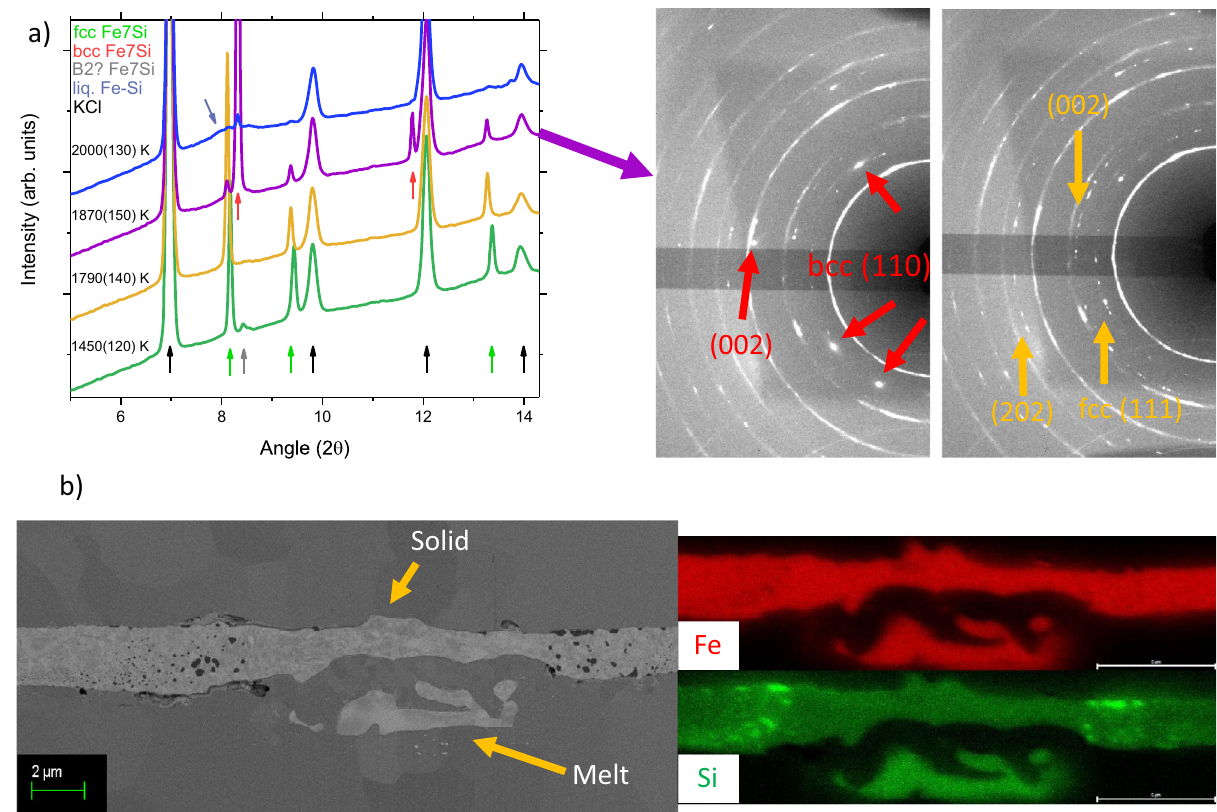
Fig. 1 In situ X-ray diffraction and ex situ chemical analysis of Fe7Si. a Integrated diffraction patterns of Fe7Si at 17 ± 2 GPa and 1450 – 2000 K showing a single-phase fcc structure, followed by a transition at higher temperatures to a bcc structure and then melting at the highest temperature. On the right side, diffraction images collected at 1870 K (left) and 1790 K (right) are shown, which indicate a clear change in the texture of the sample on transformation to the bcc phase and a signi fi cant loss of intensity of the fcc phase in the 1870 K image. b Textural map of Fe7Si (left), quenched from 34 ± 2 GPa and chemical analysis (right) of the hotspot showing clear enrichment of the liquid with Si, both solid and liquid compositions are homogeneous within error of the technique.